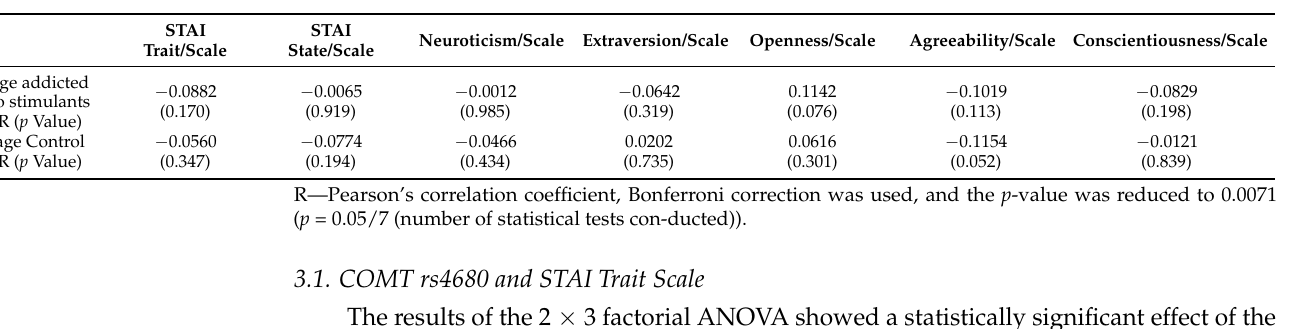
Table 5. Pearson’s correlation coefficient for age with STAI ST/NEO Five-Factor scales in stimulant addicts and controls.